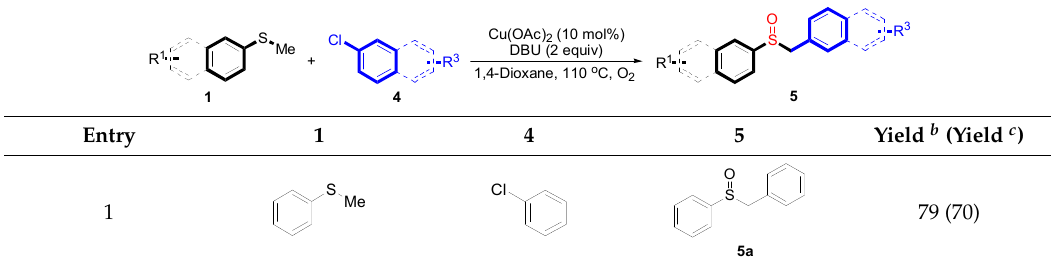
Table 2. Copper-catalyzed sulfoxidation of thioanisoles 1 with bromobenzenes 2 a .